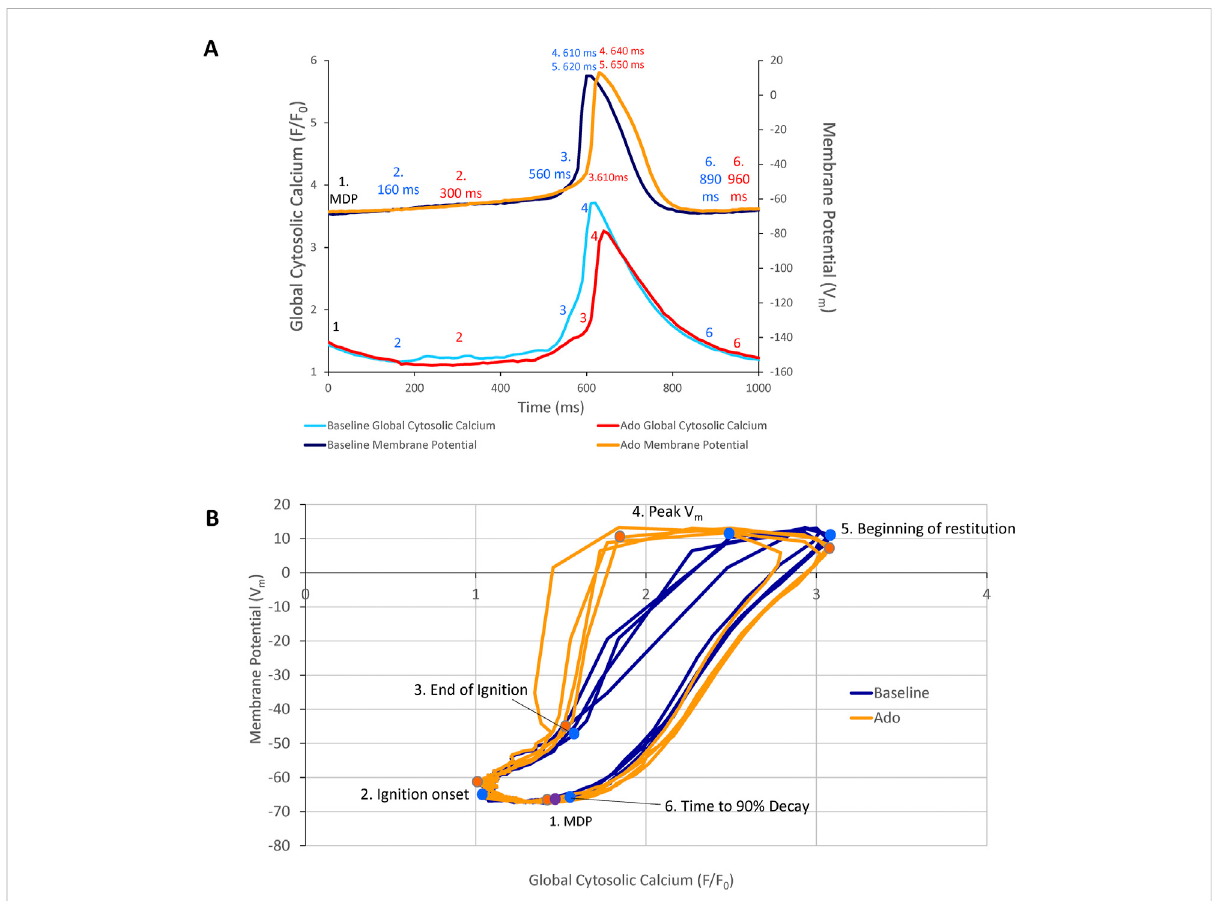
FIGURE 10 (A) Phase V m -Ca 2+ relationship. (A) one AP cycle (* in Figure 5) prior to (baseline) and during adenosine (Ado) superfusion in which V m and Ca 2+ weremeasuredsimultaneously. (B) phaseV m -Ca 2+ diagramdepictingtherelationshipbetweenV m andglobalcytosolicCa 2+ duringseveralAPcycles (electrochemical gradient oscillations) at baseline (blue) and with adenosine (orange); 4 consecutive cycles from Figure 5 are shown. Numbers 1 – 5 indicate the times during the AP cycles in Panel (A)